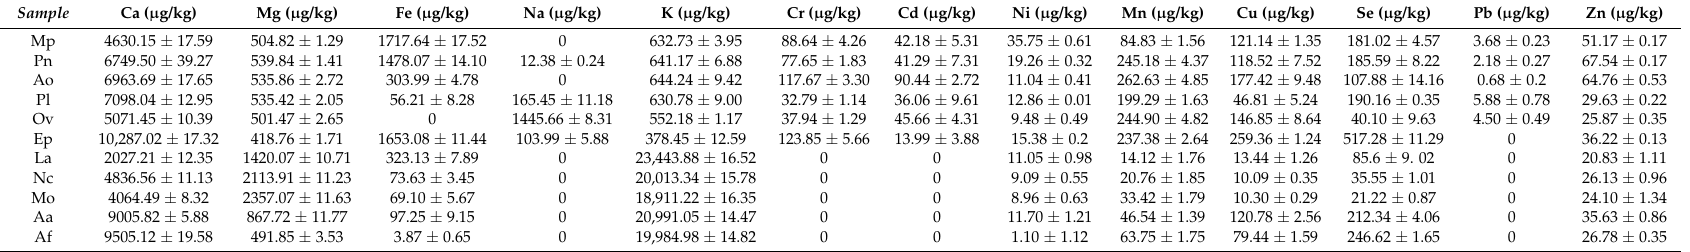
Table 2. Macroelements and microelements content of plant samples. Results are given as mean ±